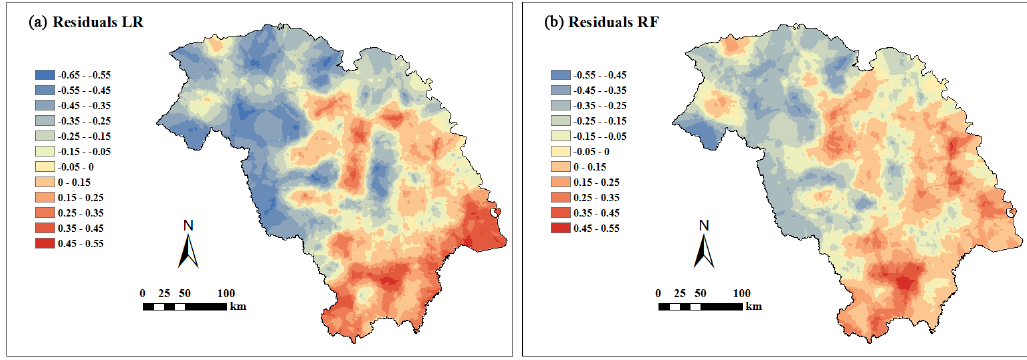
Figure 7. Spatial distribution of model residuals of logistic regression (a) and Random Forests (b) models.